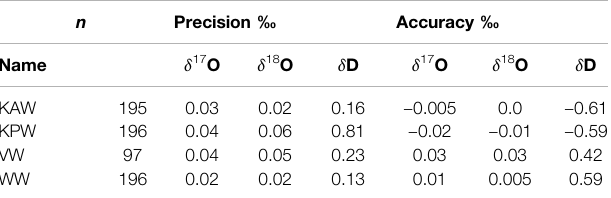
TABLE 2 | Precision and accuracy of reference waters measured as unknowns. n (cid:1) number of independent measurements. n Precision